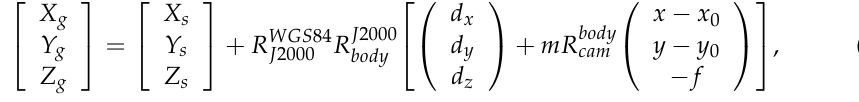
(cid:3) T Z s represents the origin position of the is the J 2000